Question: How would you classify this visualization?
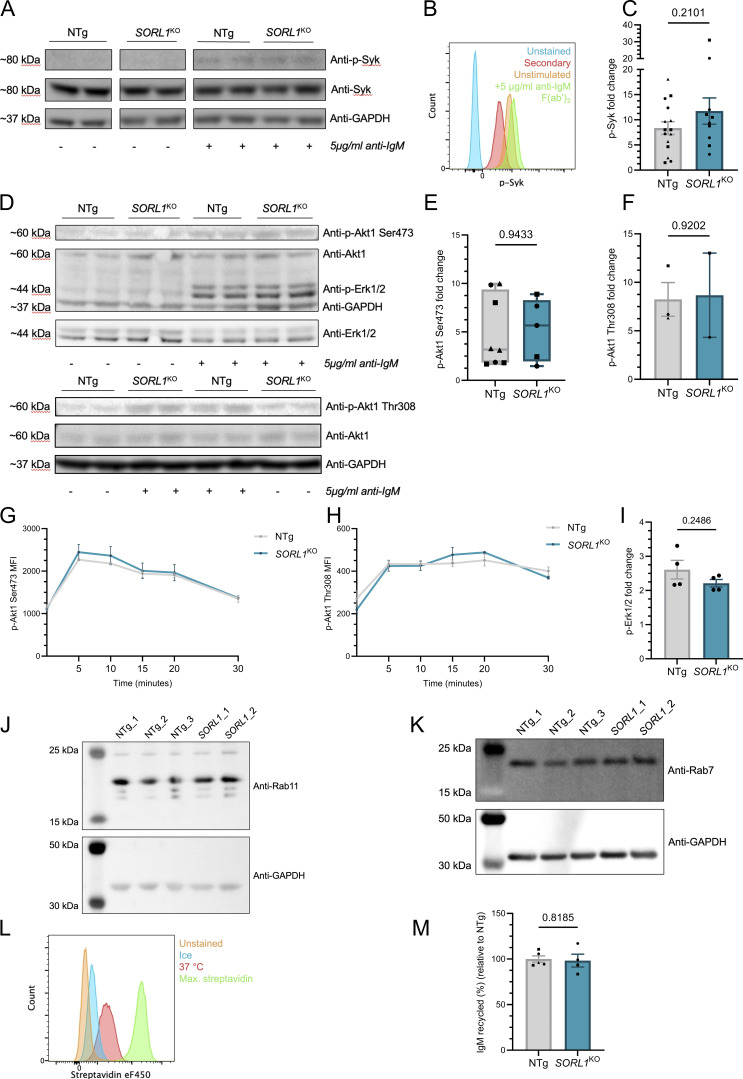
Answer: histogram